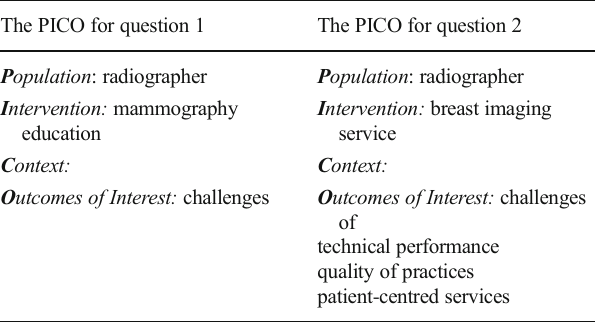
The PICOs in search questions 1 and